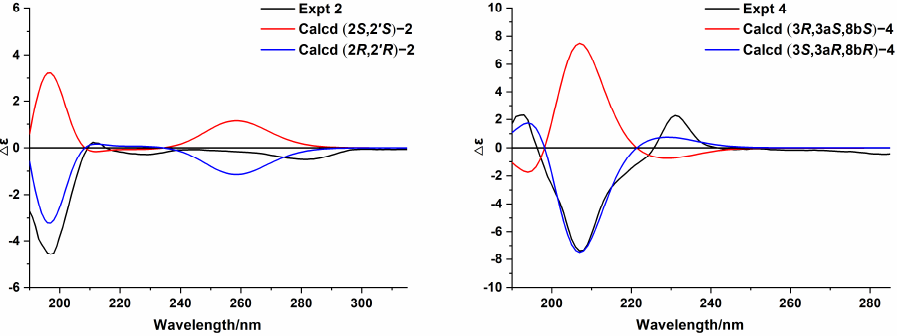
Figure 4. Experimental and calculated ECD spectra of compounds 2 and 4